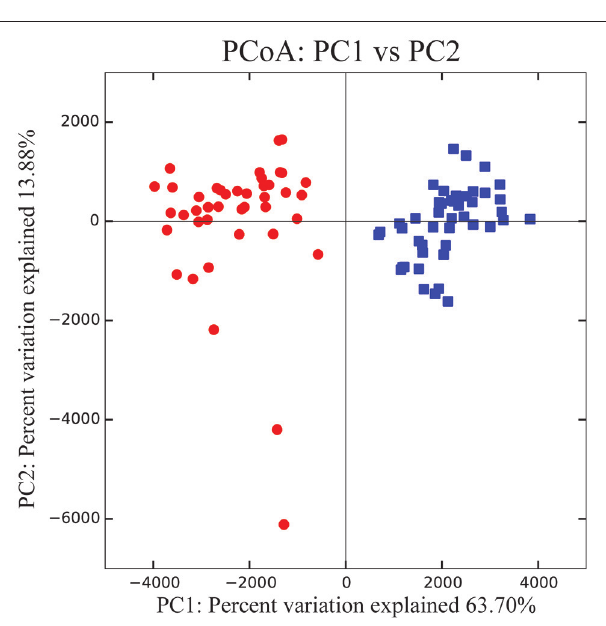
FIGURE 4 | PCoA plot showing PC1 vs. PC2 using Euclidean distance (Bray-Curtis distance yielded nearly identical results). Red circles indicate samples collected from the PAG, while blue squares indicate samples collected from the